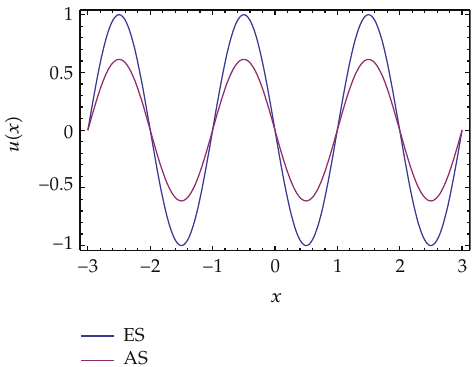
Figure 3: The compared results of the analytical and numerical solutions of Example 4.1 for t (cid:3) 1 . 5.